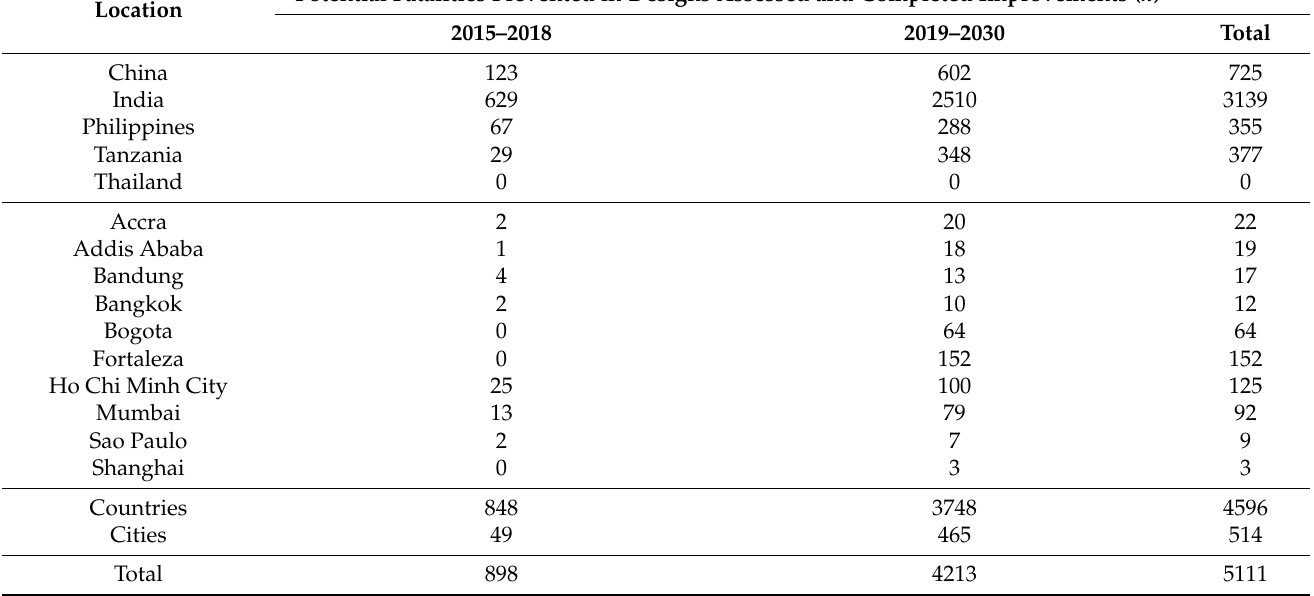
Table A7. Estimates of Lives Saved from International Road Assessment Programme (iRAP) Assessments of Road Infras- tructure Improvements Program under the Guidance of the World Bank Global Road Safety